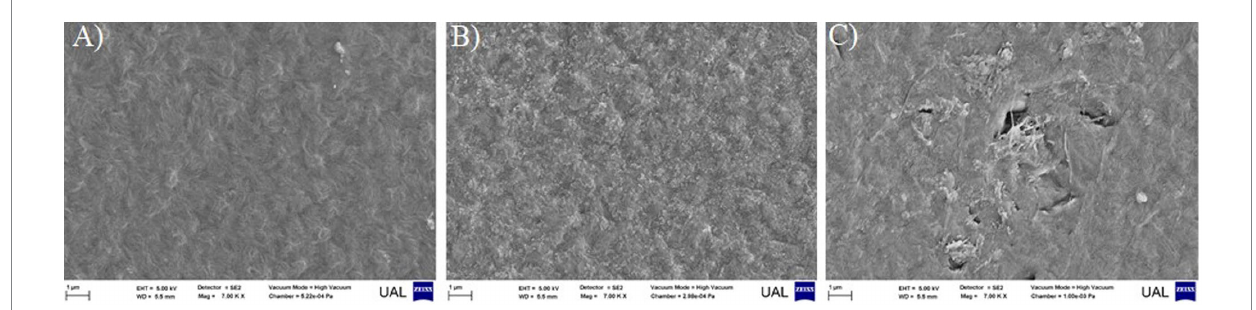
FIGURE 4 Micrographs of the LLDPE film surface observed by FESEM after 3 months of incubation. (A) LLDPE films no treated with MSM medium nor microbial inoculum, (B) LLDPE film treated with MSM medium without carbon nor inoculum, and (C) LLDPE film inoculated with P. alloputida REBP7 in MSM medium without